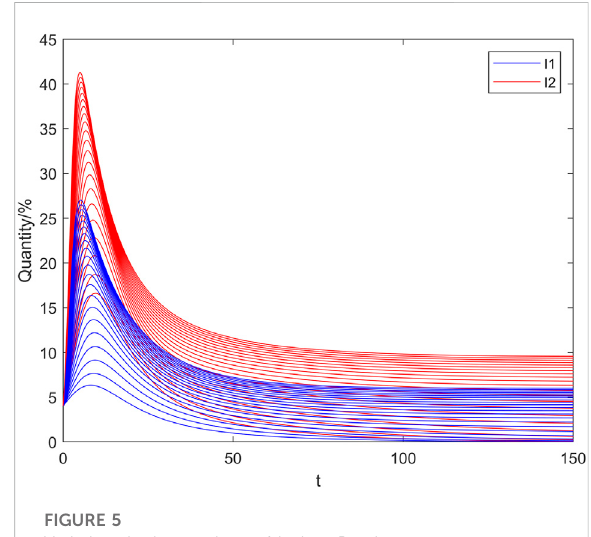
FIGURE 5 Variations in the numbers of I when R 0 > 1.